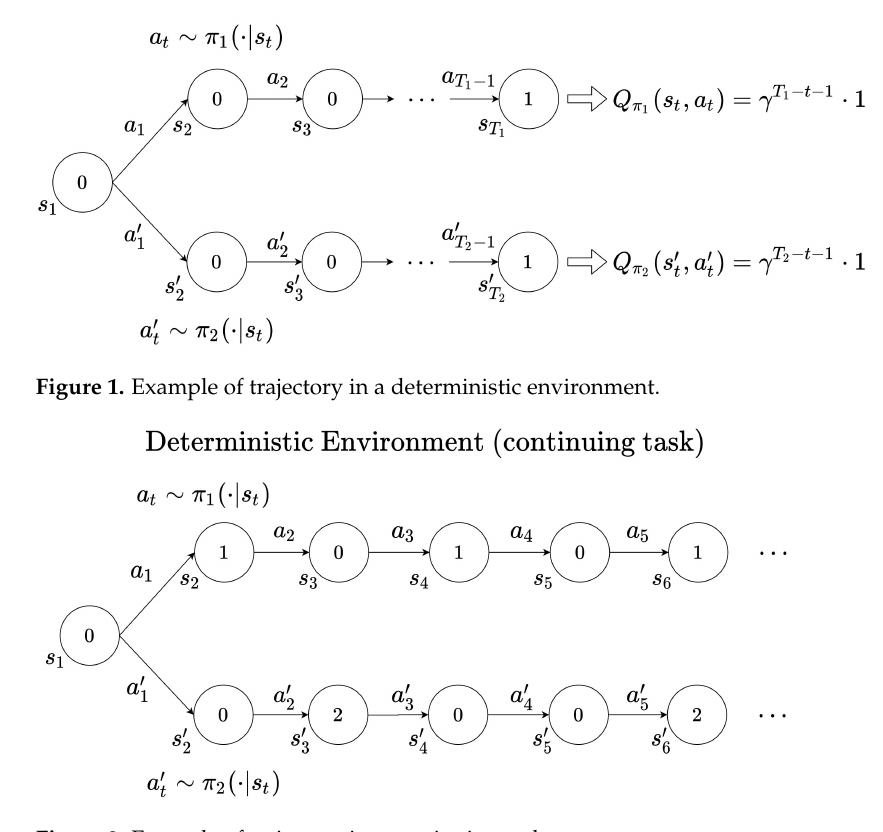
Figure 2. Example of trajectory in a continuing